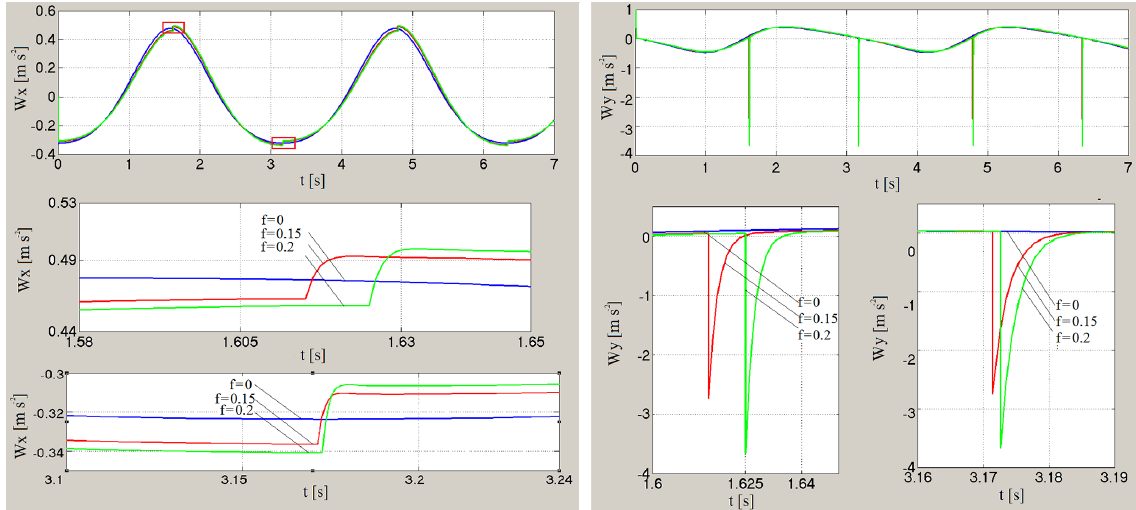
Figure 17. Graphs of acceleration projections Wx ( t ) and Wy ( t ) of point C for different values of the coefficient of sliding friction f and for coefficient of rotational friction k = 0 and load mass M = 70kg.